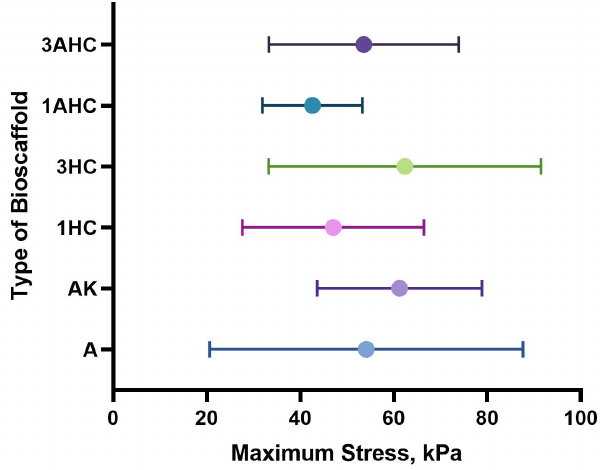
Figure 8. Degradation rate results of bioscaffolds taken on days 3, 7, 10, 14, 21, and 28. The statistical significance was considered at a probability of p < 0.05 (* p ≤ 0.05, ** p ≤ 0.01, *** p ≤ 0.001).